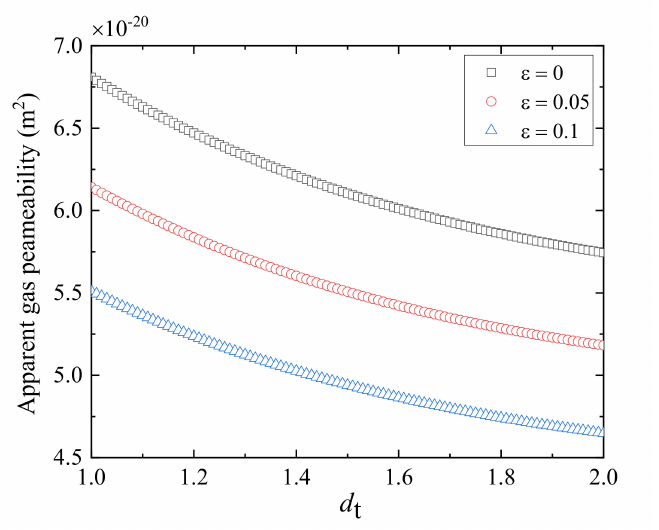
Figure 6. The impact of tortuosity fractal dimension on the apparent gas permeability at different relative